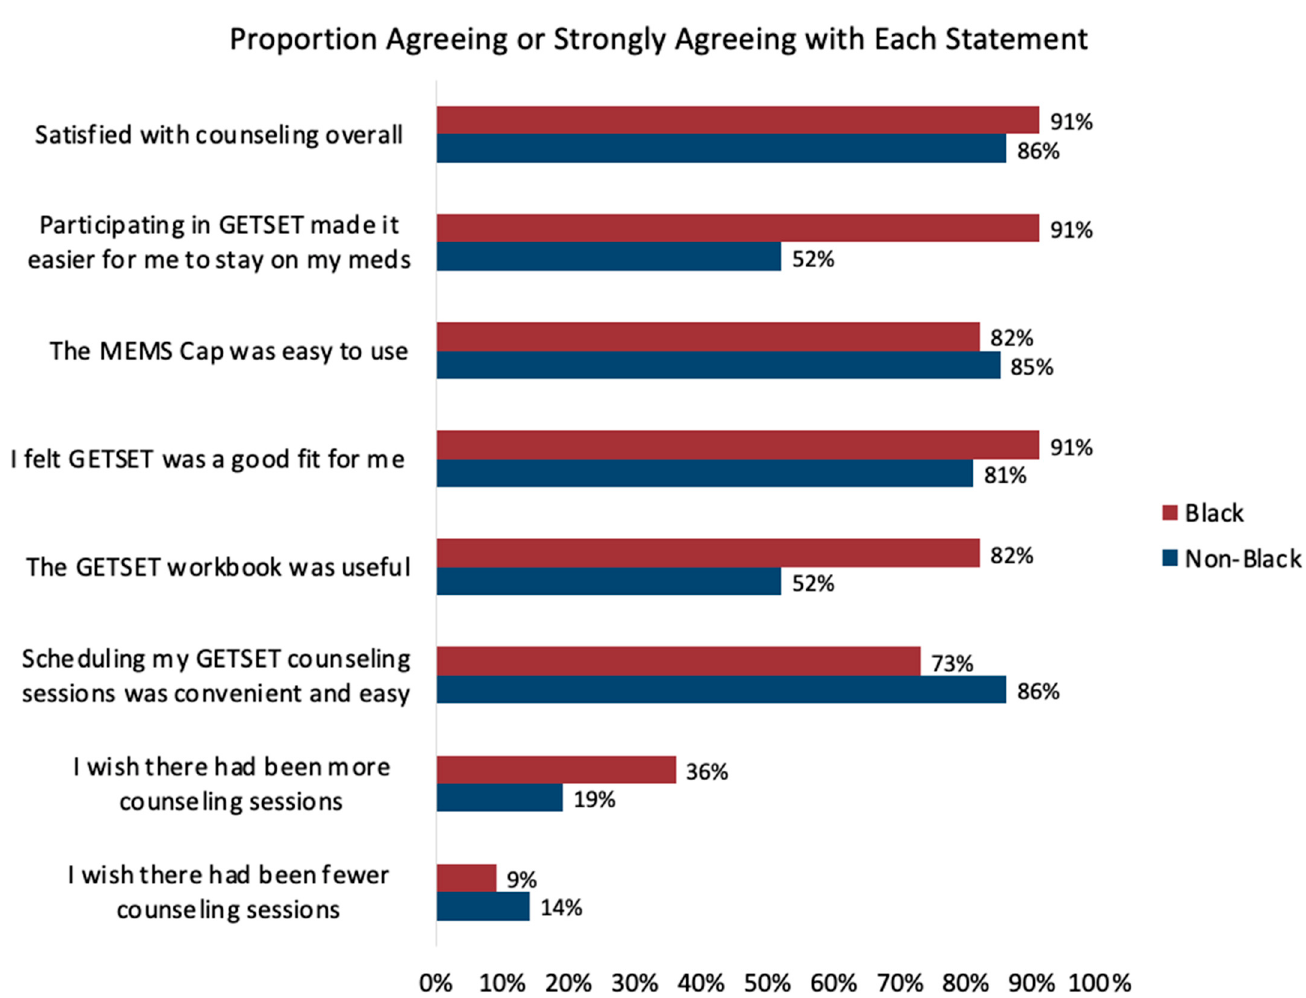
Figure 3. GETSET feasibility and acceptability outcomes by